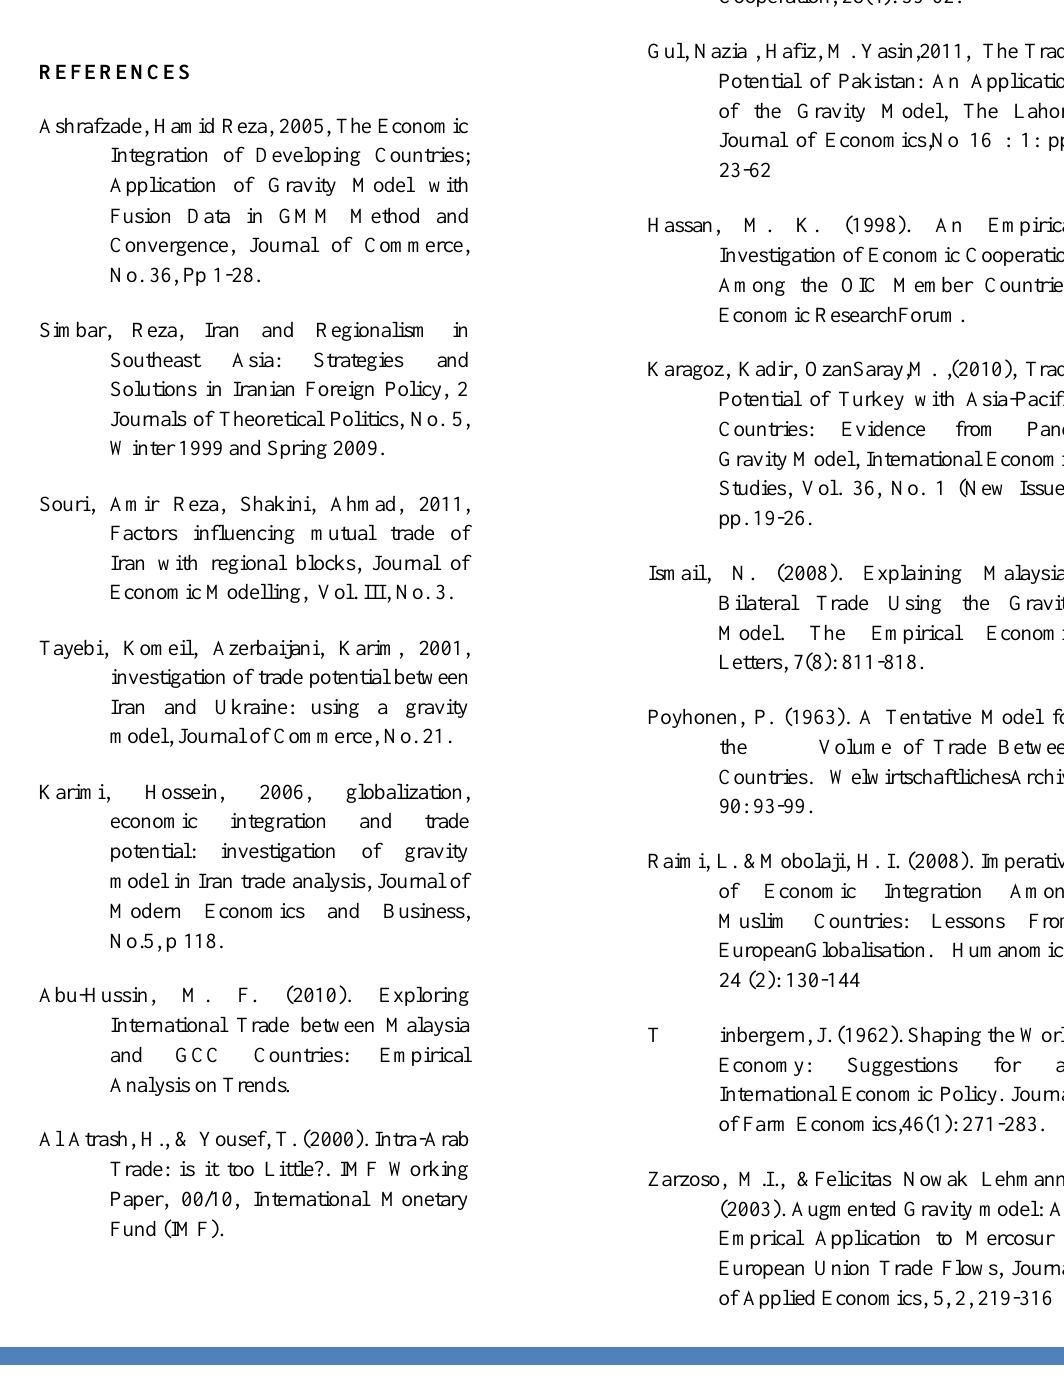
Fig.1. mean trade gap of Iran with selected